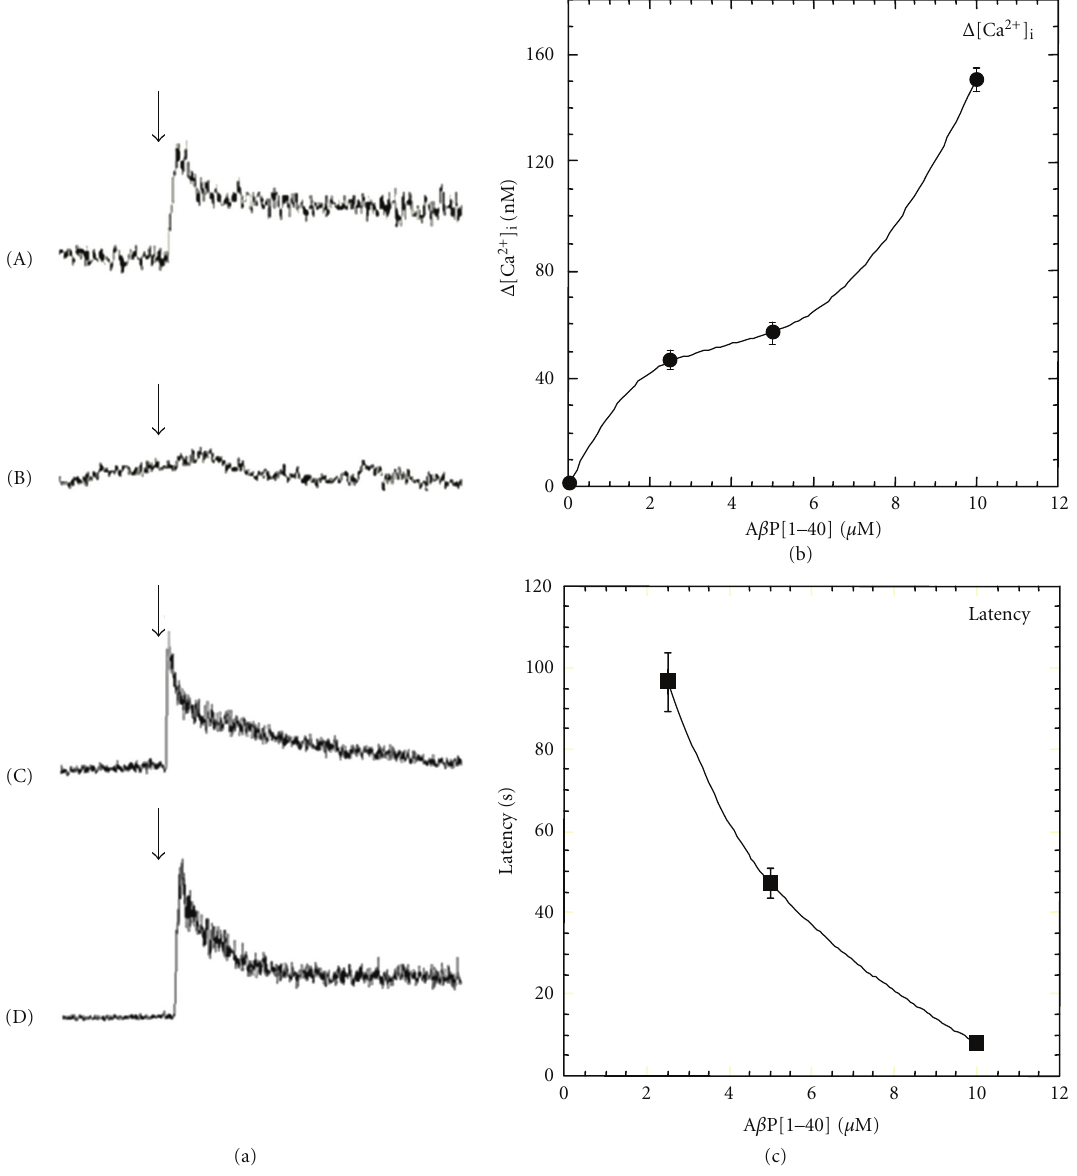
Figure 2: Characteristics of A β P-induced elevations in [Ca 2+ ] i . (a) Typical time course of [Ca 2+ ] i prior to 2 min and after 3 min of the application of the peptide is depicted. Concentration is 10 μ M for all peptides used. (A) A β P(1–40); (B) A β P(40-1); (C) A β P(1–42); (D) D- A β P(1–40). The arrow indicates the time of peptide addition. (b) and (c) Dose-dependence of the increase in [Ca 2+ ] i . Typical responses of [Ca 2+ ] i in cultured neuronsfollowingexposure to variousconcentrationsof A β P(1–40)(2.5 ∼ 10 μ M).The peak increase in [Ca 2+ ] i ( Δ [Ca 2+ ] i ) in each cell (b) and the latency after exposure to A β P(1–40) were analyzed in more than 50 neurons in field of view (360 × 420 μ m) cultured neurons (mean ± S.E.M., n =